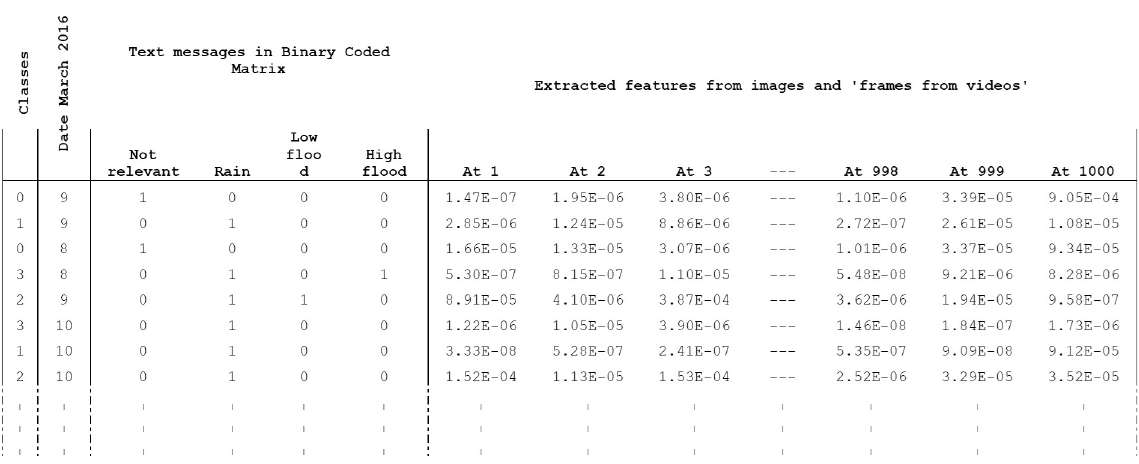
Fig 4. Sample data from 2,171 rows showing binary coded matrix of text messages and extracted features from images and frames.